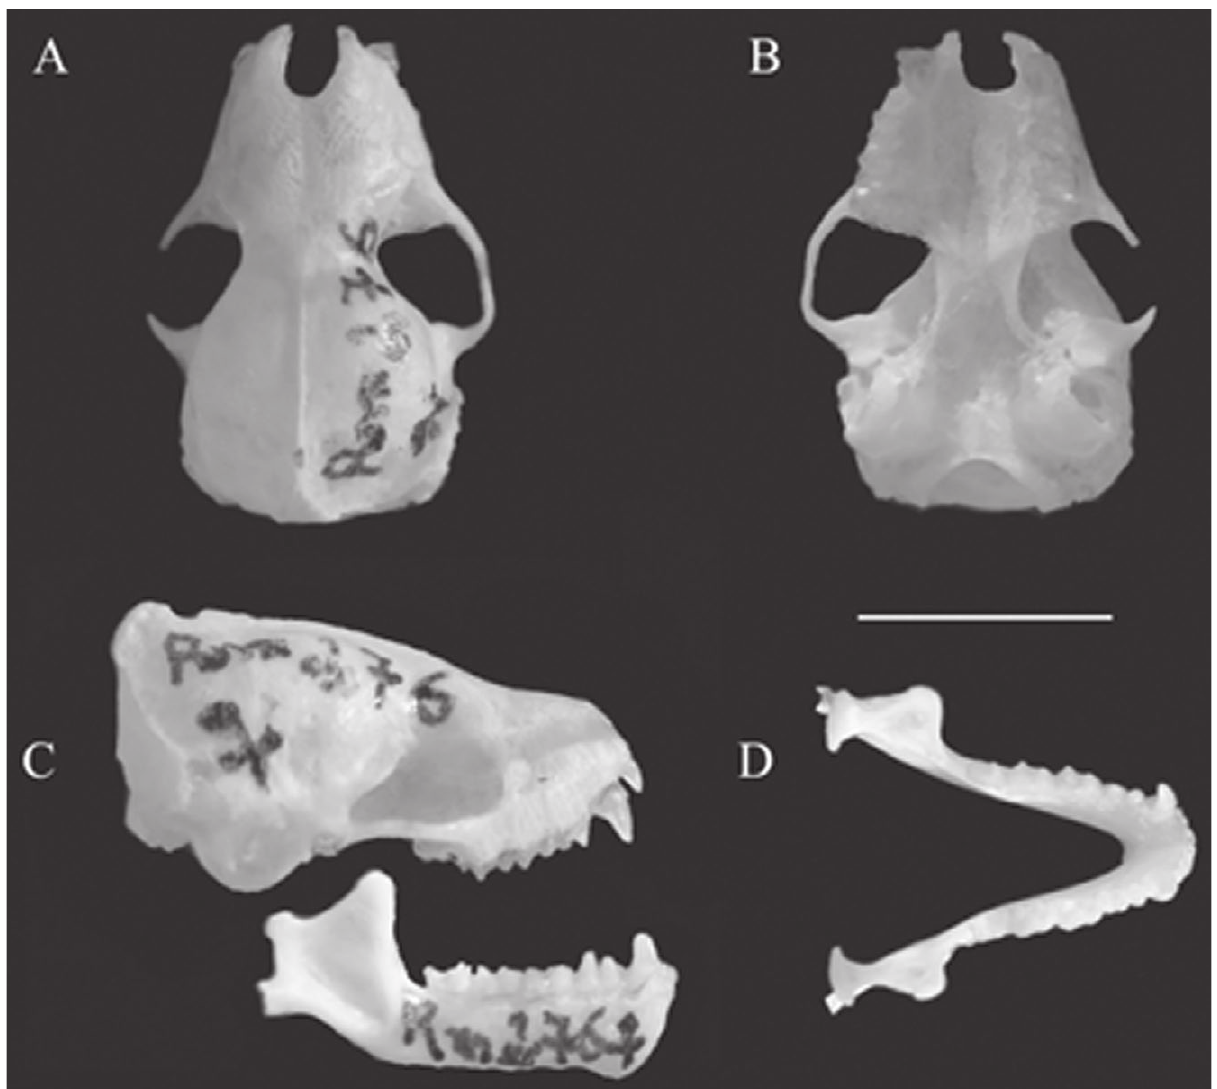
Figure 1. Dorsal view of skull (A), ventral view (B), lateral view (C), and ventral view of mandible (D) (RM 276), specimen of R. hussoni (adult female), deposited in the Scientific Collection of Chiroptera/UNEMAT, campus Nova Xavantina, state of Mato Grosso, Brazil (bar scale